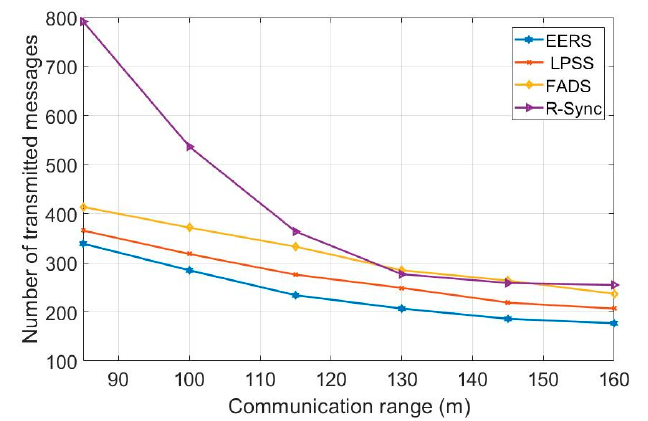
Figure 6. Required number of messages for synchronization process (r = 85 m: 160 m, N = 240).